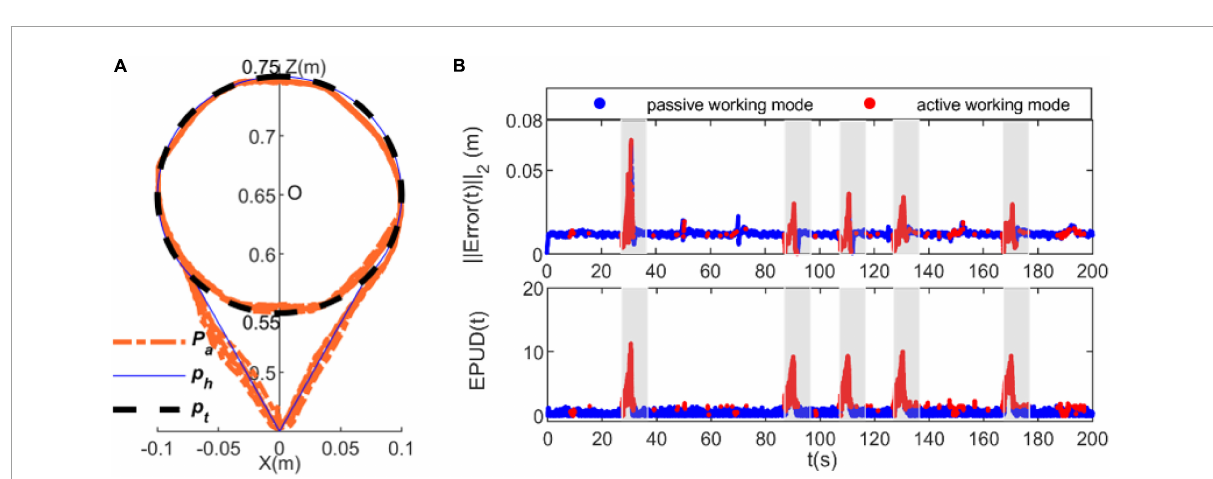
FIGURE8 Experimental results of subject 2 when using the proposed RLOAC. (A) Tracking trajectories, (B) tracking error and